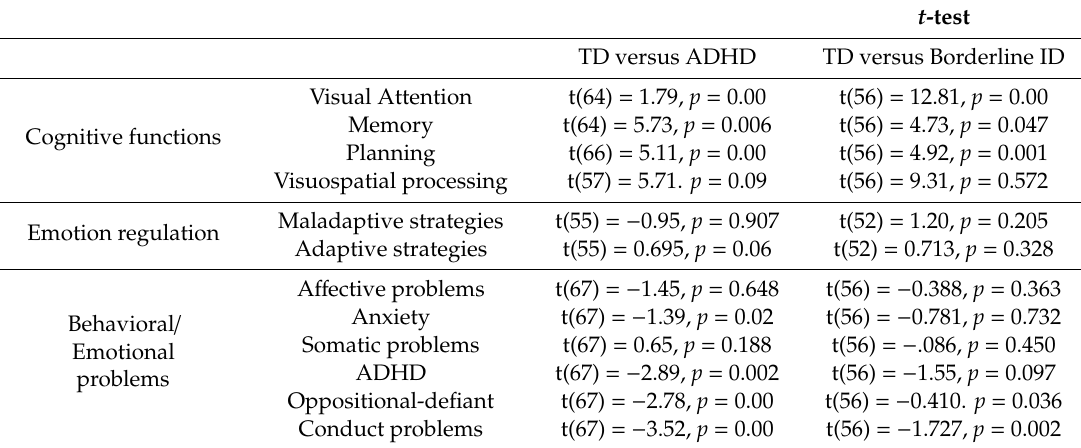
Table 2. Di ff erences between TD, ADHD, and borderline ID children.